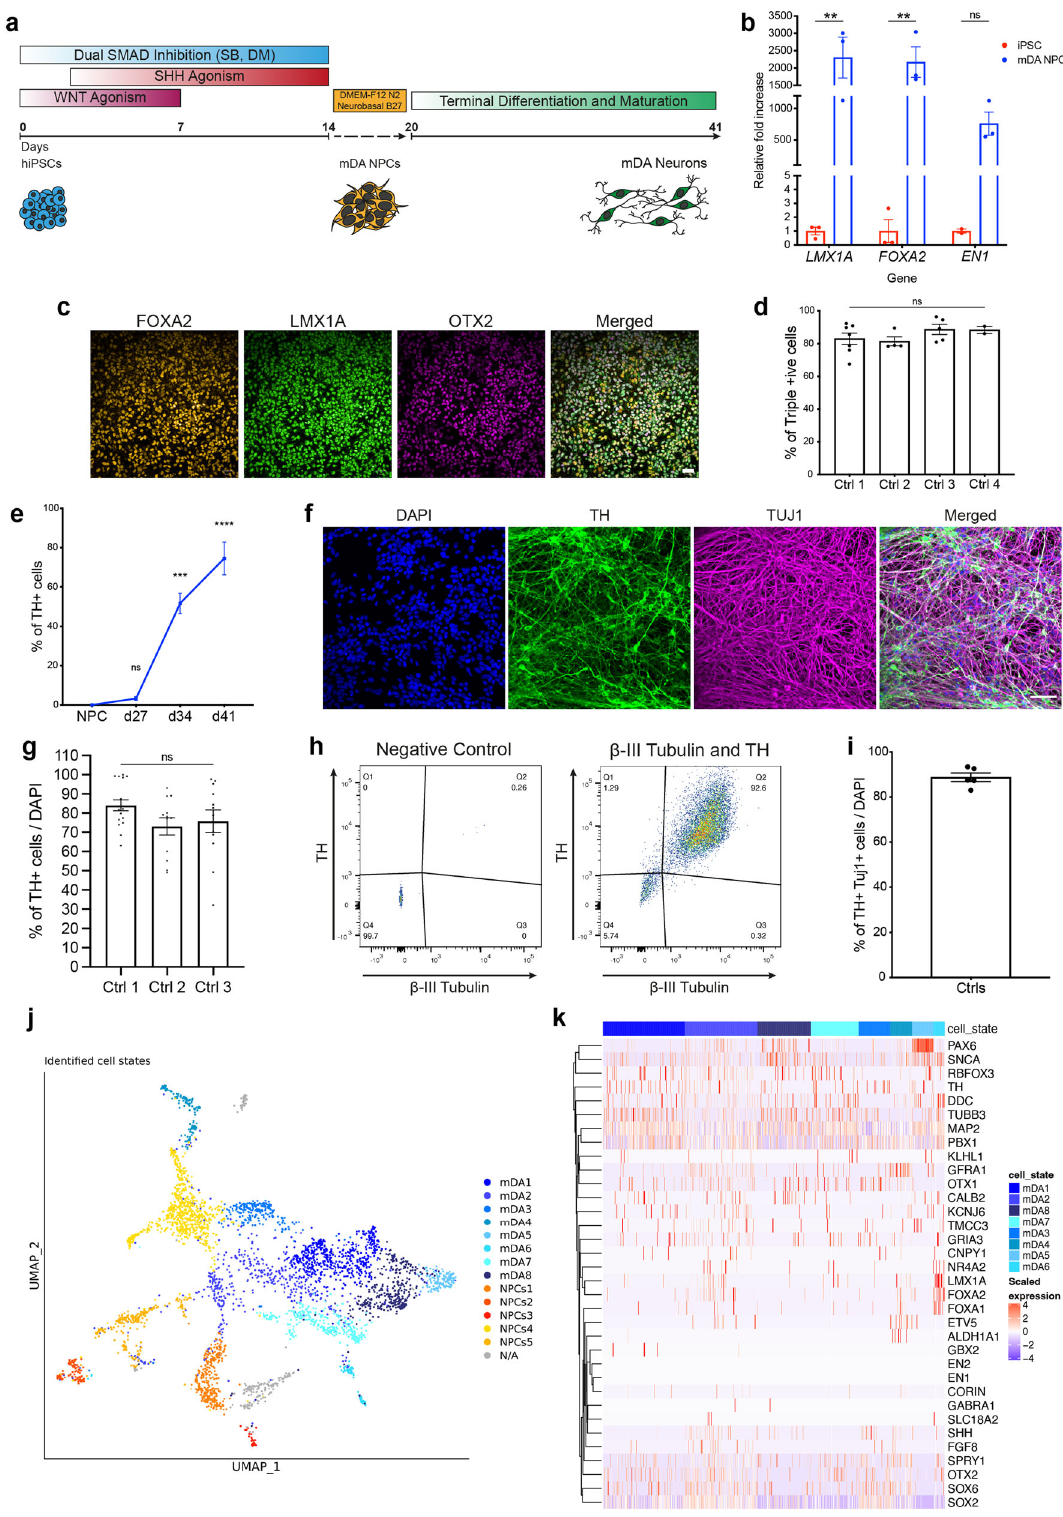
receptors, shown by the triggered single-channel openings in outside-patches pulled from cell soma upon application of 10 mM glutamate + 10 mM glycine, and fully inhibited by further application of 50 mM APV, a selective antagonist of NMDA receptors (Fig. 3e). Whole-cell voltage-clamp recording